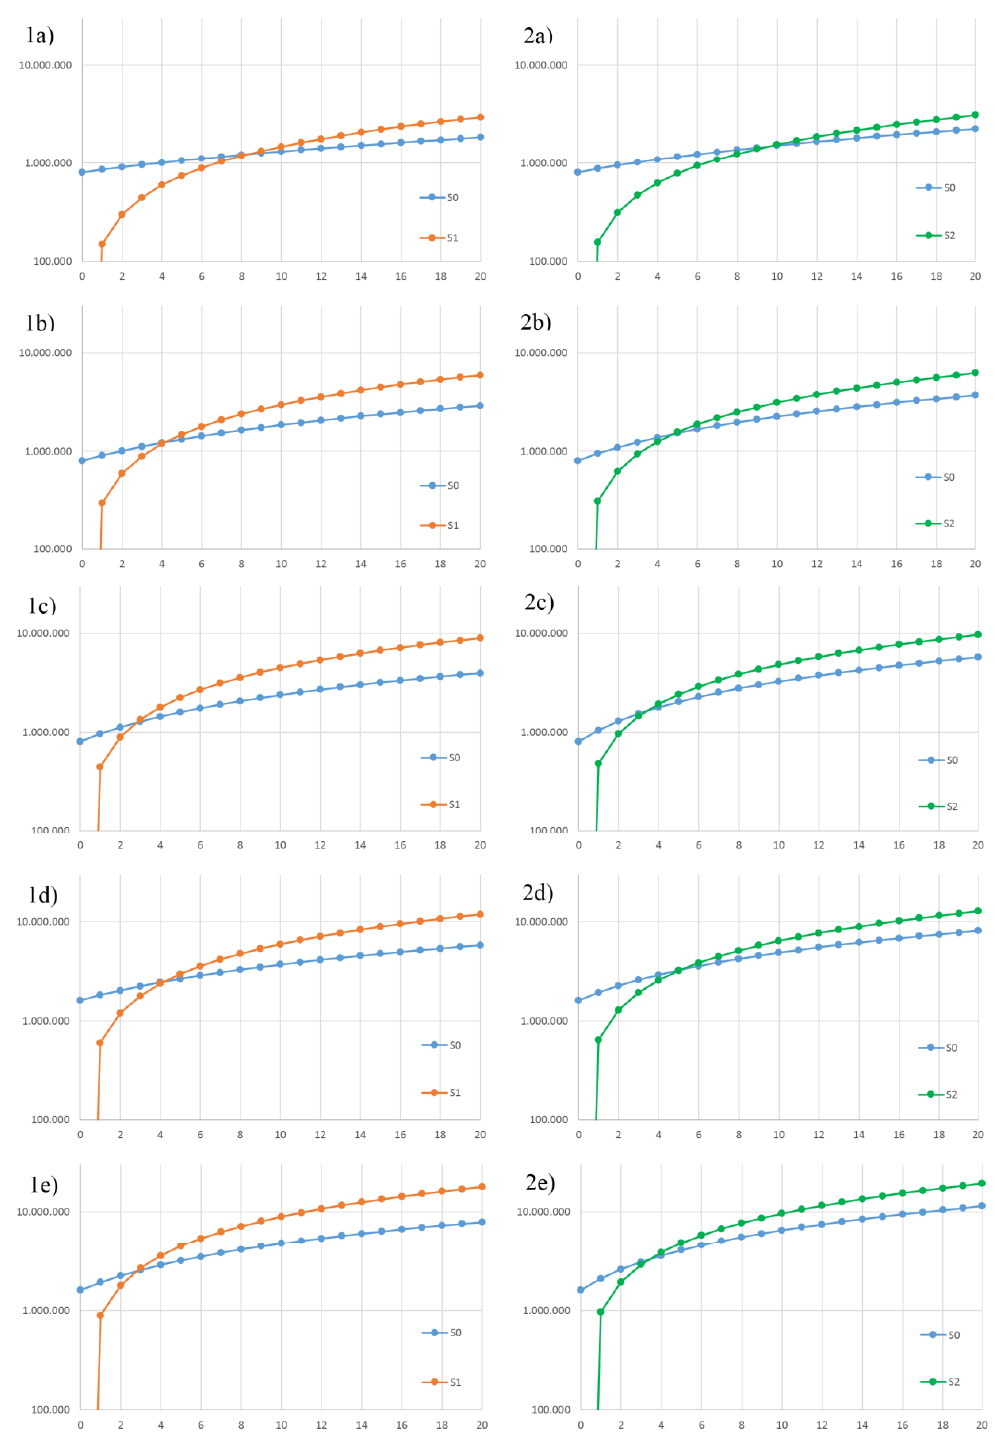
Figure 3. Results from the cumulative net cost analysis for Scenario 1 ( 1 ) and Scenario 2 ( 2 ), both compared to Scenario 0, for Nc equal to ( 1a,1b ) 5, ( 1b,2b ) 10, ( 1c,2c ) 15, ( 1d,2d ) 20 and ( 1e,2e ) 30. Note that the x axis stands for project years and the y axis stands for cumulative net cost values (log scale).